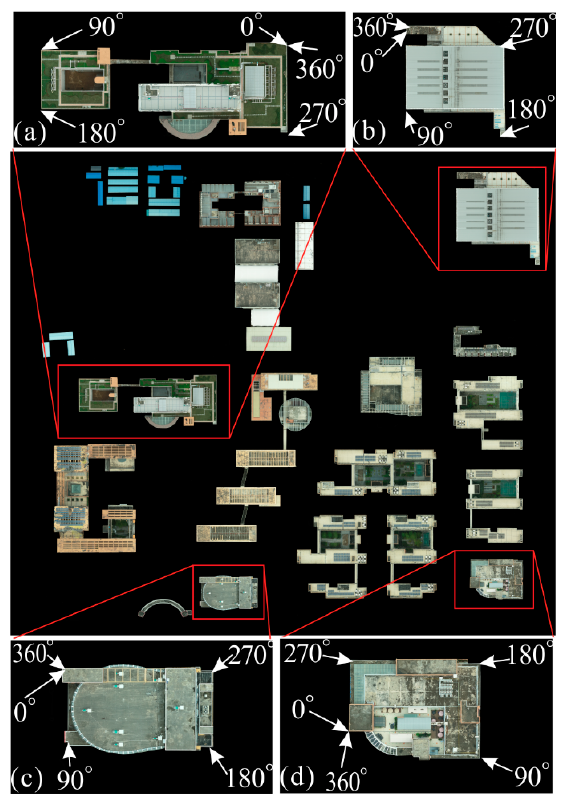
Figure 17. Generation results of DBM-based T 2 OM on dataset 2. ( a – d ) are enlarged windows of the four regions. four